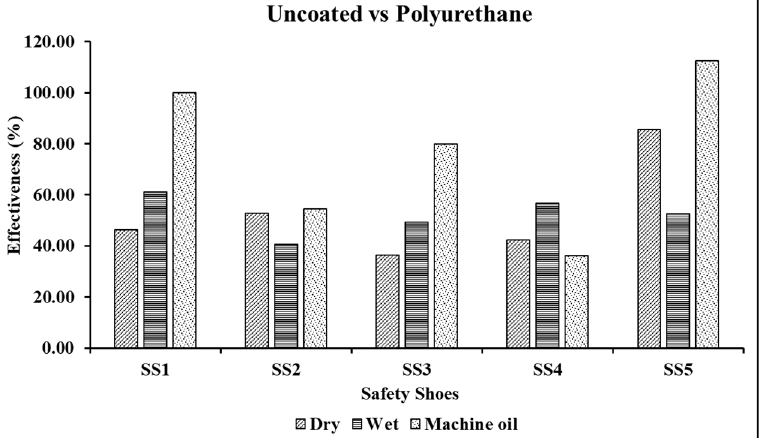
Figure 10. Effectiveness of polyurethane-based coating as compared to uncoated laminate flooring across dry, wet, and machine oil contaminant conditions.